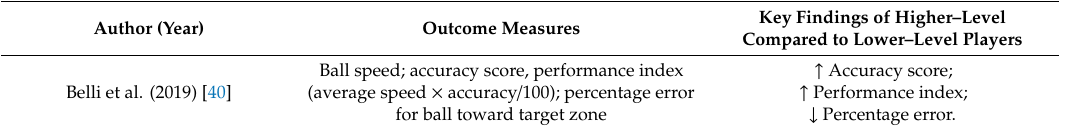
Table 3. Key findings of included studies comparing playing